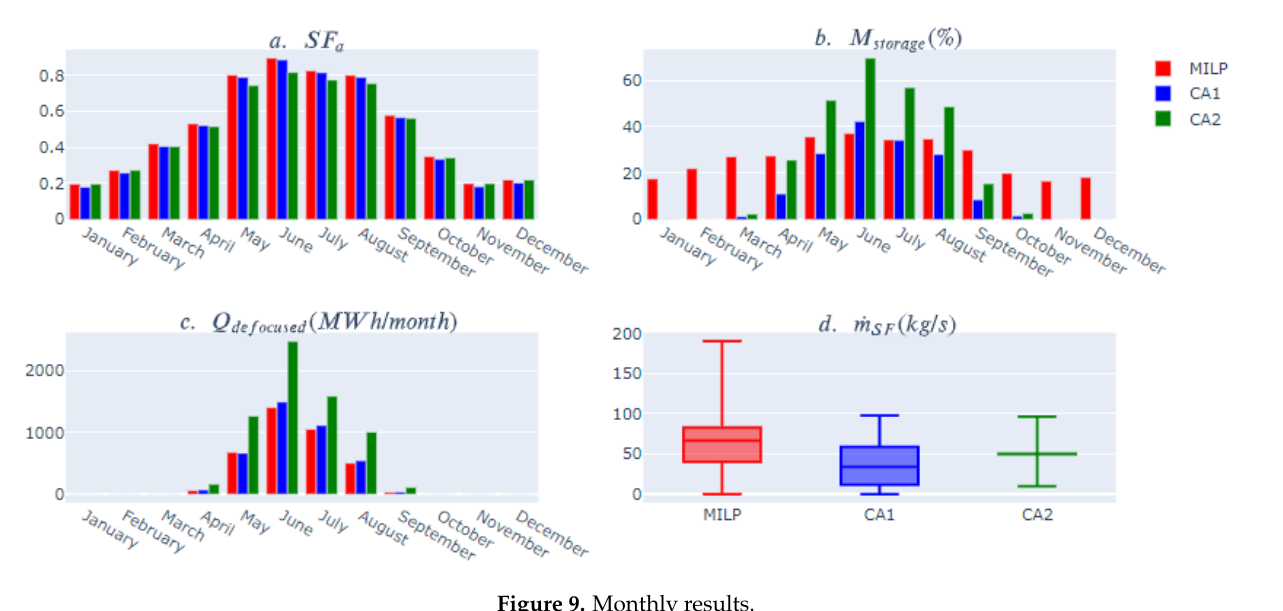
Figure 9. Monthly results.